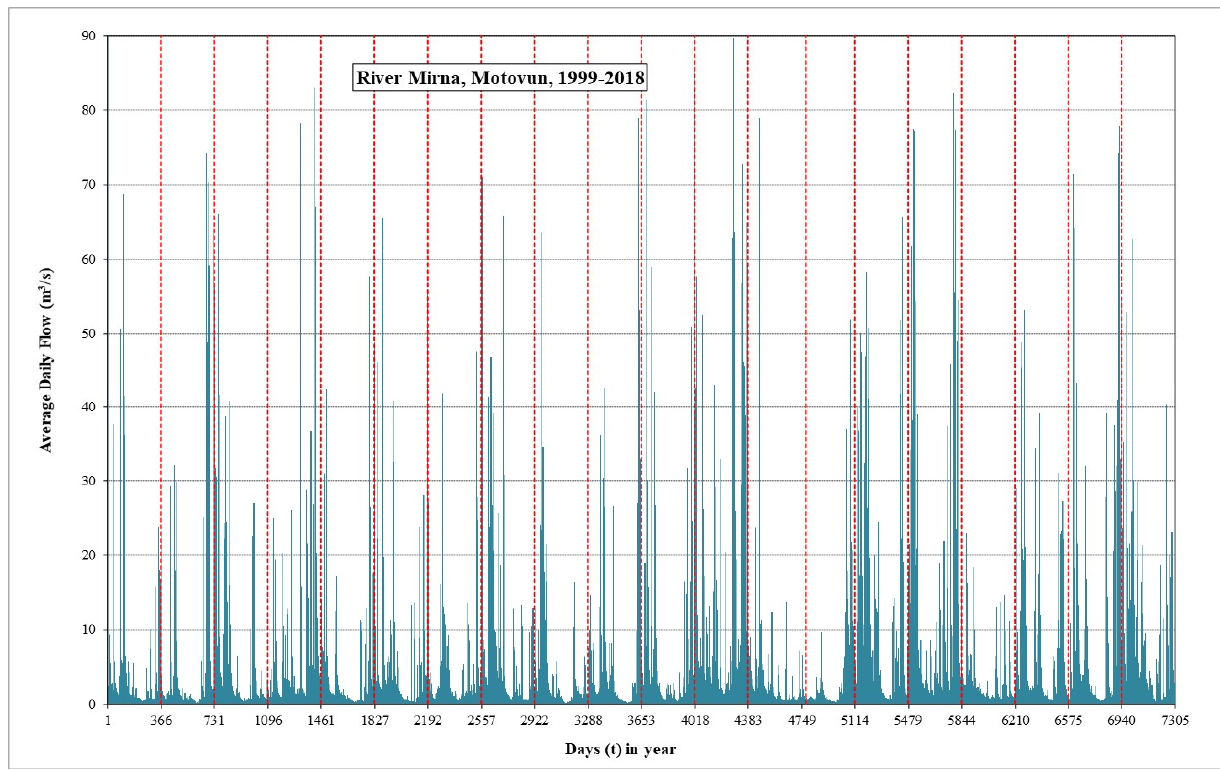
Figure 6. Average daily flow for the river Mirna, 2020 .